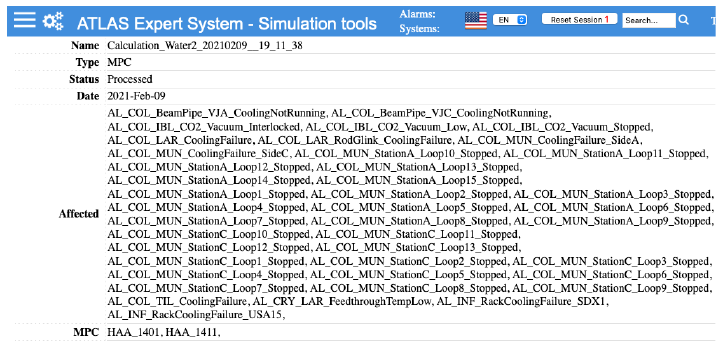
Figure 5. MPC algorithm performance. Left: Average processing time vs maximum number of results. Figure 6. Screenshot of the MPC result for a potential scenario occurring during the annual mainte- nance of the chilled water